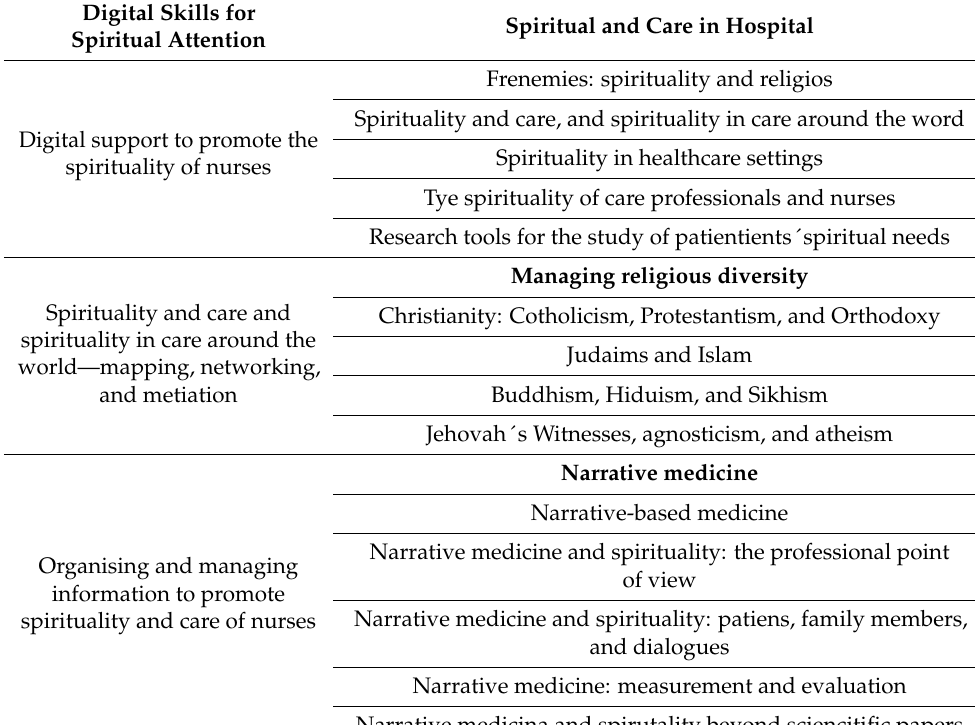
Table 2. Learning matrix between digital skills and spiritual